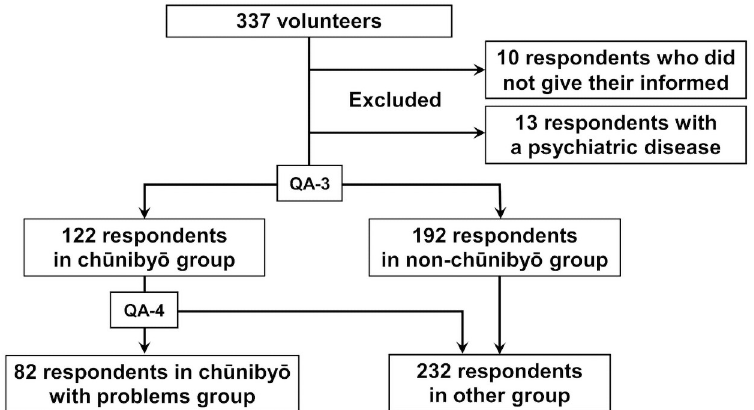
Fig 1. The flowchart of the study. QA-3: Did you experience ch ū niby ō during your middle/high school years? Respondents who replied “Yes” or “I do not think I did, but I was told I did.” were classified in the ch ū niby ō group, and respondents who replied “No” or “I am not sure if I did, and nobody said I did” were classified in the non- ch ū niby ō group. QA-4: Have you had any problems due to ch ū niby ō or any other problems related to puberty? Respondents who selected items other than “No nor have I had ch ū niby ō ”were classified in the other group, and the rest were classified in the ch ū niby ō with problems group.